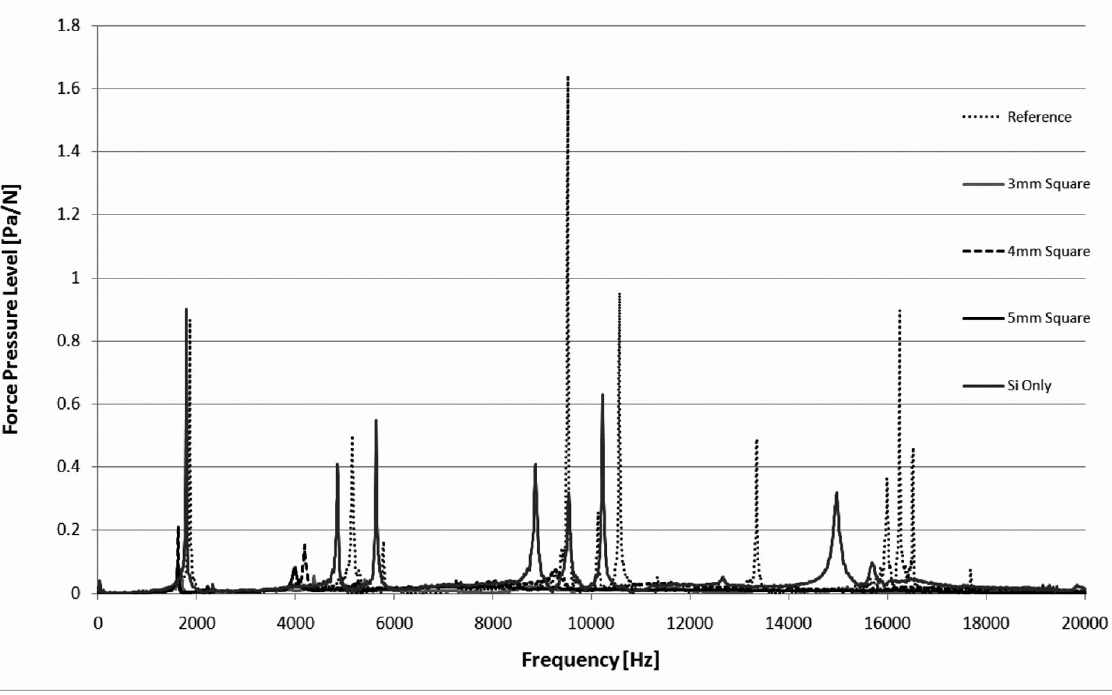
Fig. 70. Microphonics measurements for Square EIDL